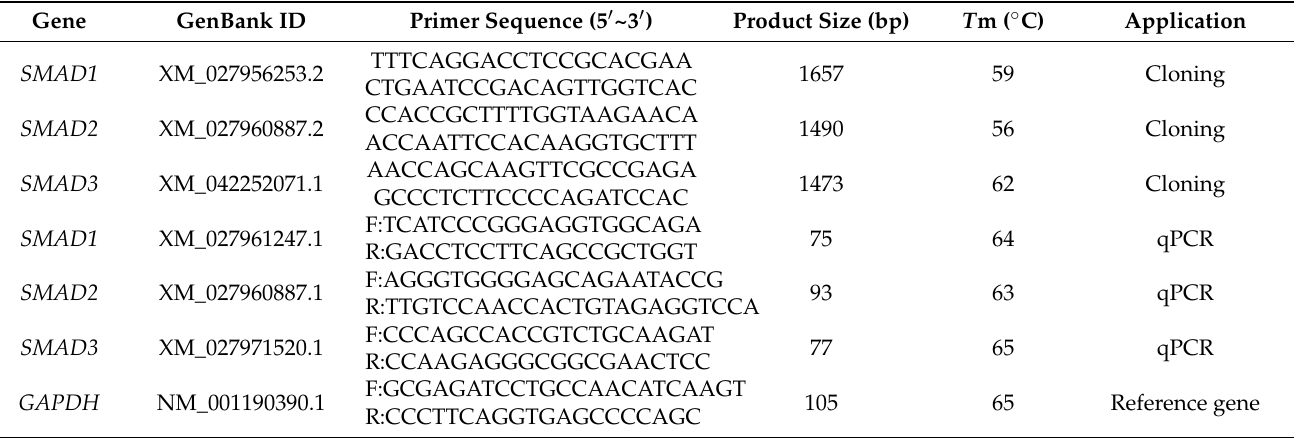
Table 1. The primer sequence information used for the cDNA cloning and expression analysis of Smad1 , Smad2 and Smad3